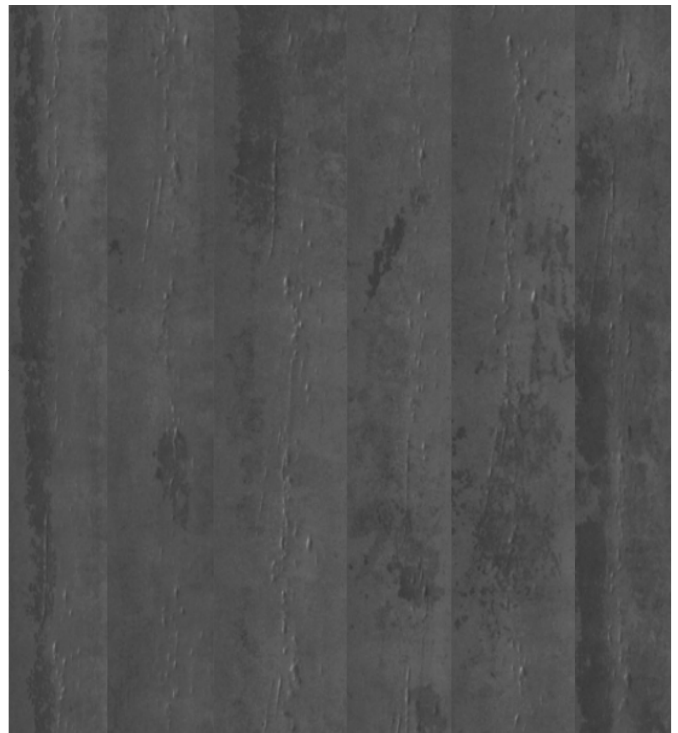
Figure 3. Roll marks on different batches.